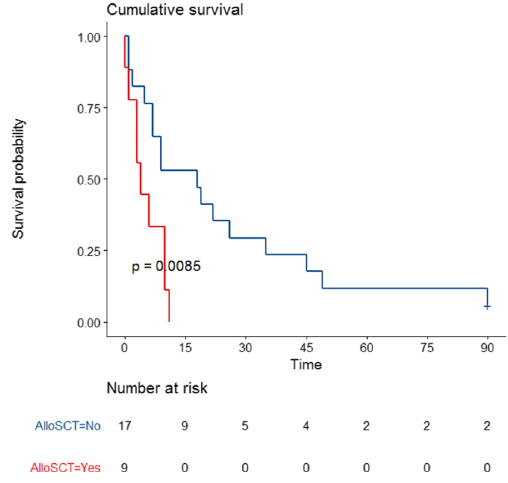
Fig. 1 Kaplan‑Meier curve reporting unadjusted influence of allogenic stem cell transplantation (alloSCT) F‑101 Prediction of clinical phenotypes with